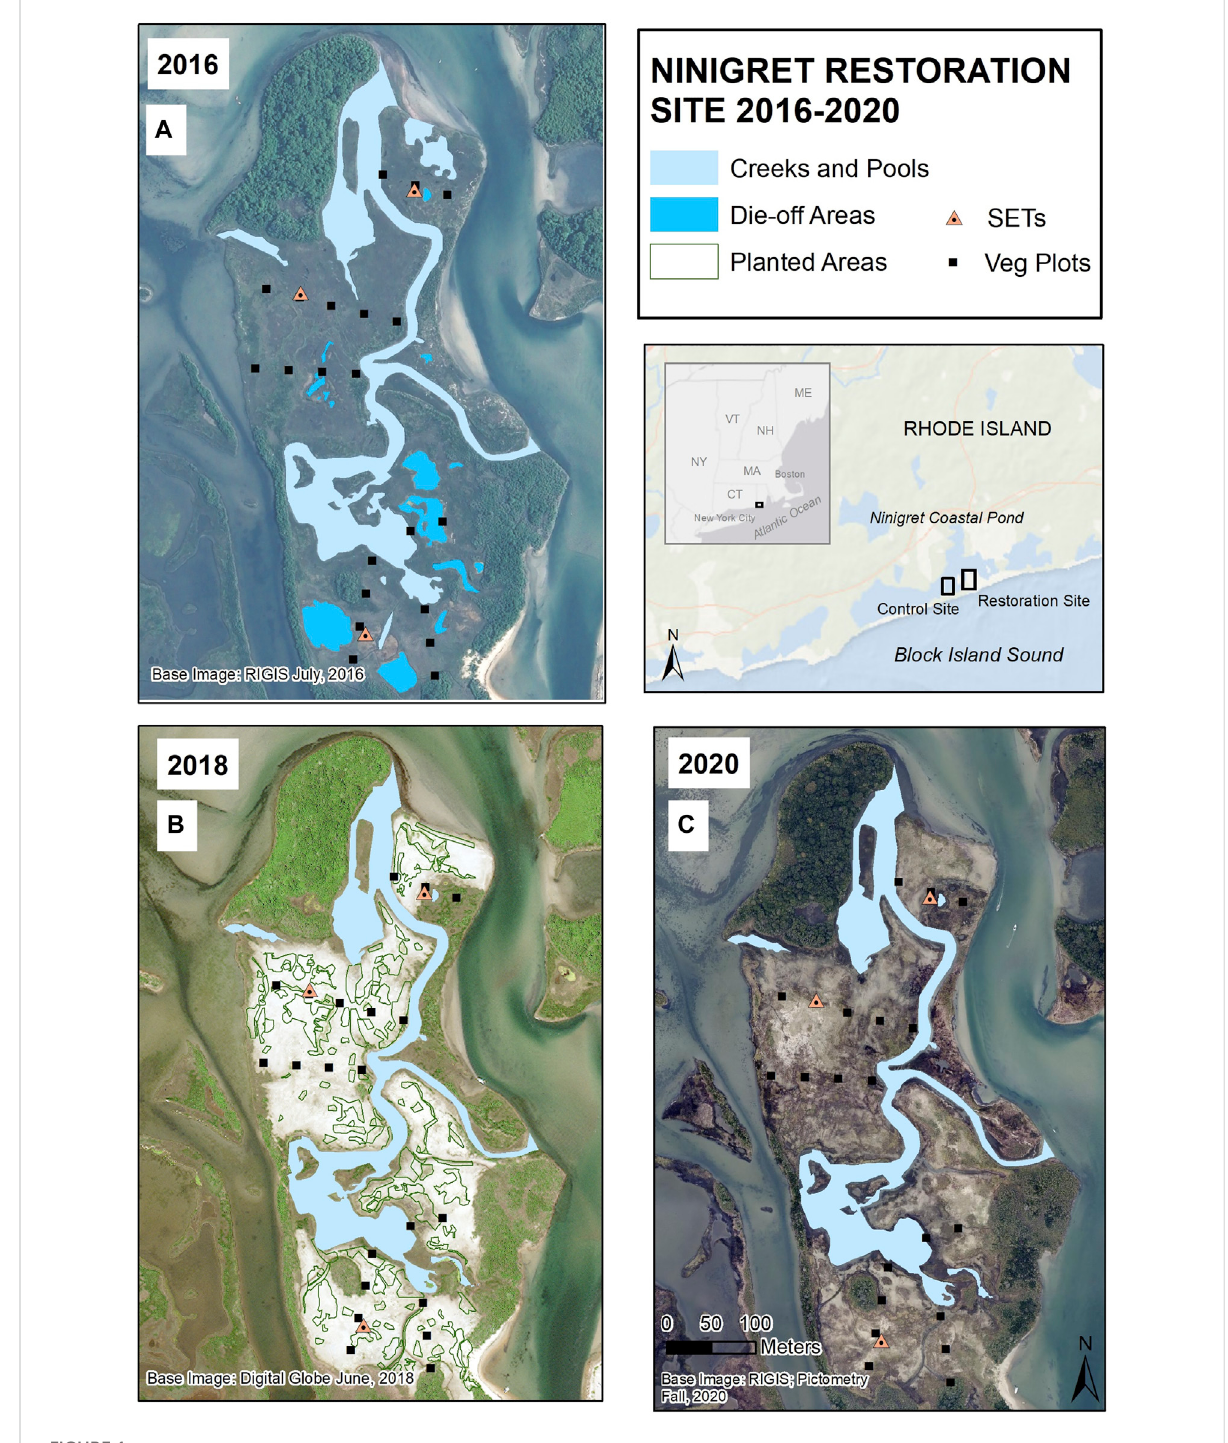
FIGURE 1 Locus maps showing the Ninigret sediment placement site in Ninigret Pond, Charlestown RI, and time-series aerial photo maps showing (A) initial degraded conditions in 2016, (B) expansive unvegetated areas in 2018 two summers after sediment placement (with polygons depicting the estimated outlines of planted areas) and (C) vegetation re-growth in 2020. Vegetation monitoring plots and surface elevation tables (SETs), none of which werelocated in planted areas, are shown on each map. Note that the 2016 and 2018 photos weretaken in summer; the 2020 photo was taken in early